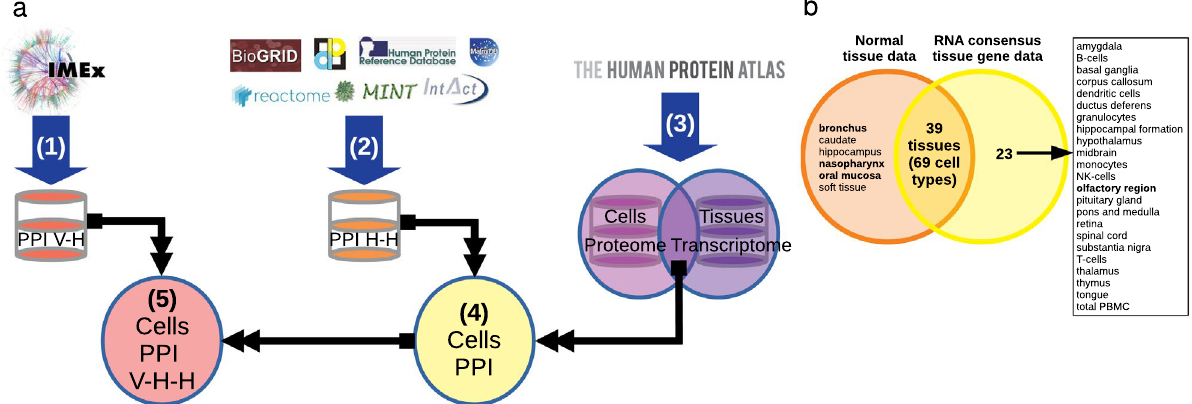
Figure 1. Research strategy. 1: ( a ) Obtaining the PPI of the SARS-CoV-2—Human (V-H) from IMEx; 2: Integration of human-specific PPIs from 7 primary databases (H–H); 3: Obtaining proteomes and transcriptomes, selecting those results that are reported at both levels; 4: Generation of human PPI (H–H) for each cell; 5: Obtaining the PPI of the viral infection (V-H–H) of each cell. Images were taken from https:// www. imexc onsor tium. org/, https:// dip. doe- mbi. ucla. edu/ dip/ Main. cgi, https:// www. ebi. ac. uk/ intact/, https:// mint. bio. uniro ma2. it/, https:// thebi ogrid. org/, https:// www. hprd. org/, http:// matri xdb. univ- lyon1. fr/, https:// react ome. org/ and . ( b ) Tissues and cells that shared a set of the seven cell entry proteins/genes. For six cell types there are no reports at the tissue level (transcriptome) and for 23 tissues no cells are reported